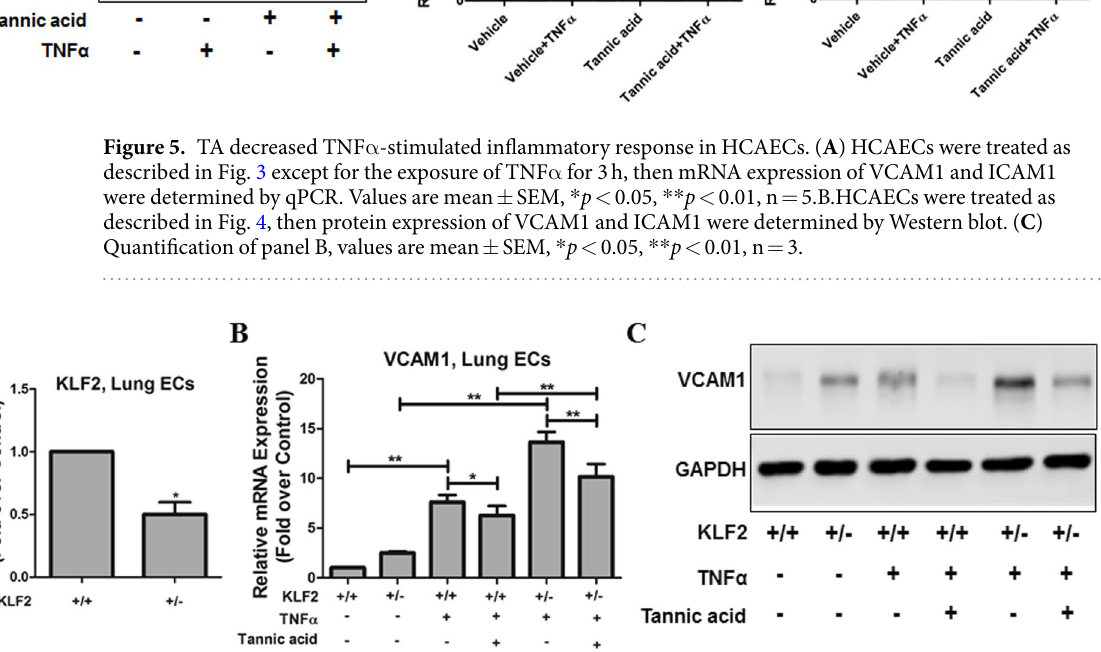
To ask whether the inhibitory effect of TA on monocyte adhesion is dependent on KLF2, we used KLF2 siRNA to knockdown KLF2 in ECs and examined its effect on monocyte adhesion. The efficiency of KLF2 siRNA (20 nM) to knockdown KLF2 in endothelial cells was analyzed by qPCR, and the results showed that about 70% KLF2 knockdown was achieved (Fig. 4C). When cells were transfected with control siRNA, TNF α significantly induced monocyte adhesion to HUVECs, and TA treatment significantly attenuated TNF α -induced monocyte adhesion (Fig. 4D,E), which was in consistent with Fig. 4A,B. When cells were transfected with KLF2 siRNA, the inhibitory effects of TA on TNF α -induced monocyte adhesion to endothelial cells was significantly reduced